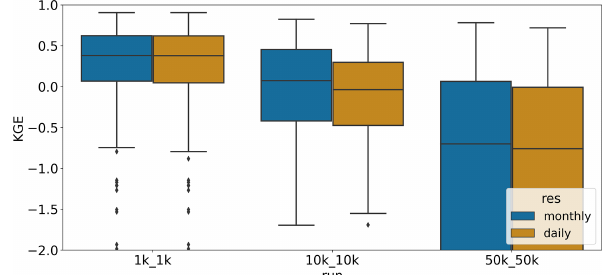
Figure 4. Comparison between KGE distribution presented as box plots for the different spatial resolution and temporal resolution of the discharge